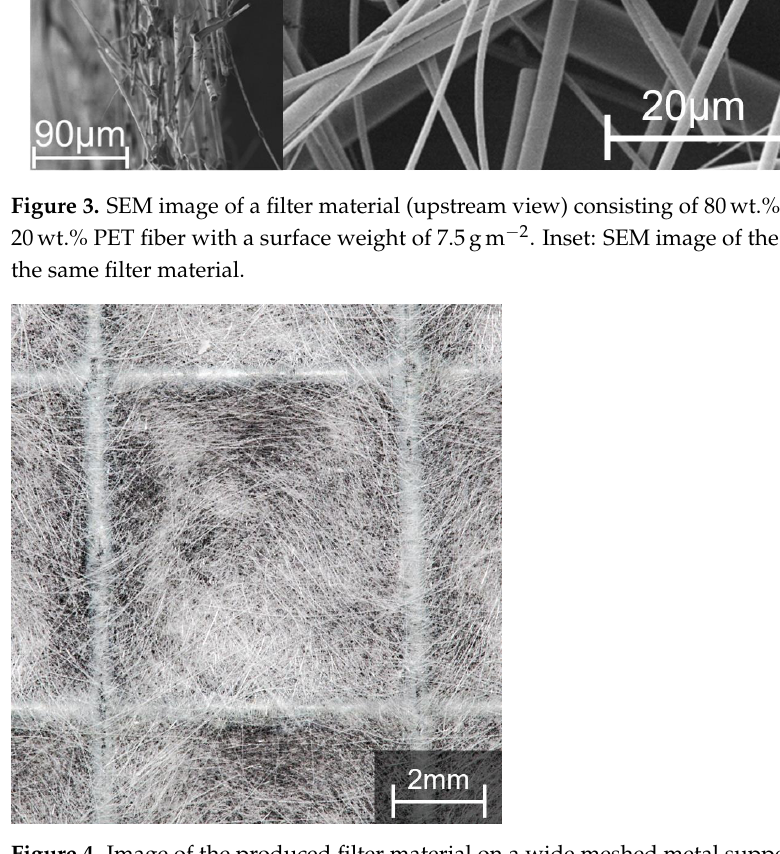
Figure 4. Image of the produced filter material on a wide meshed metal support